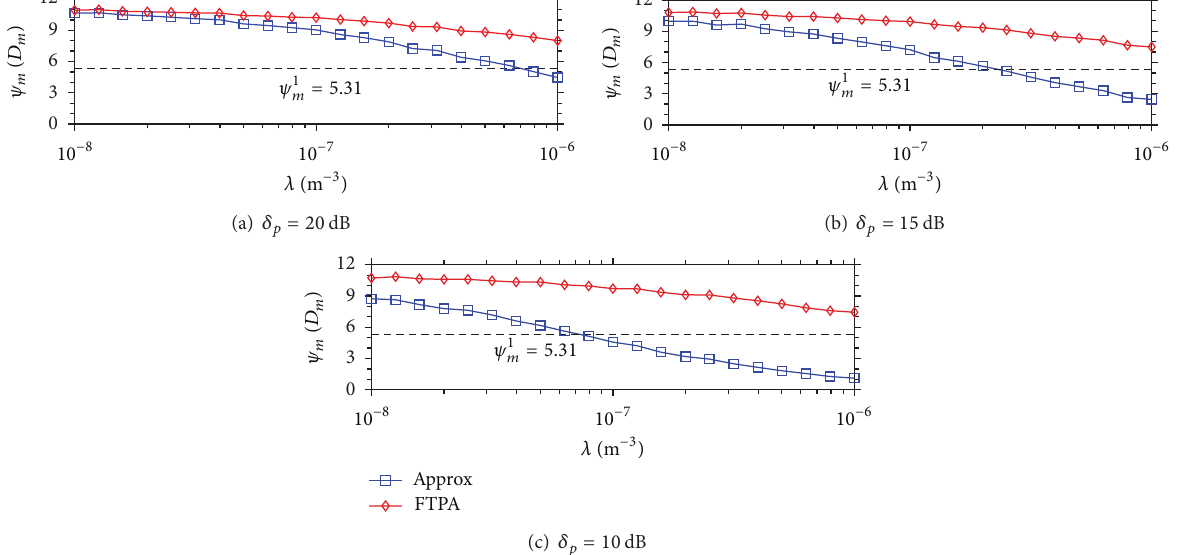
Figure 5: Mean SINR of each MU when the QoS type is voice ( 𝜓 1 𝑚 = 5.31 dB).